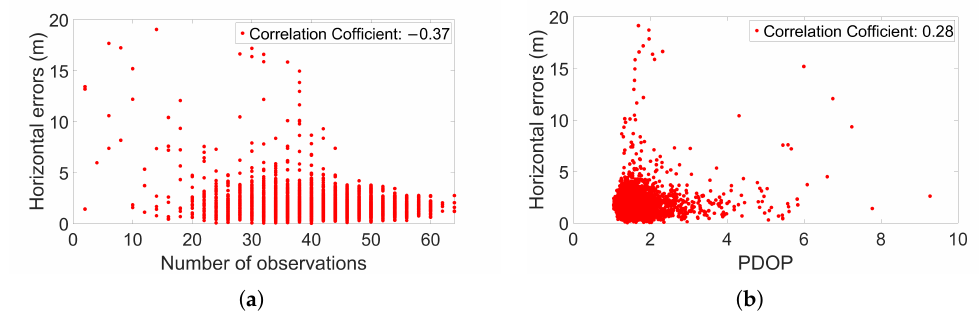
Figure 14. Correlation of the horizontal errors on the mean number of observations and PDOP. ( a ) Correlation of the horizontal errors on the number of observations. ( b ) Correlation of the horizontal errors on PDOP.